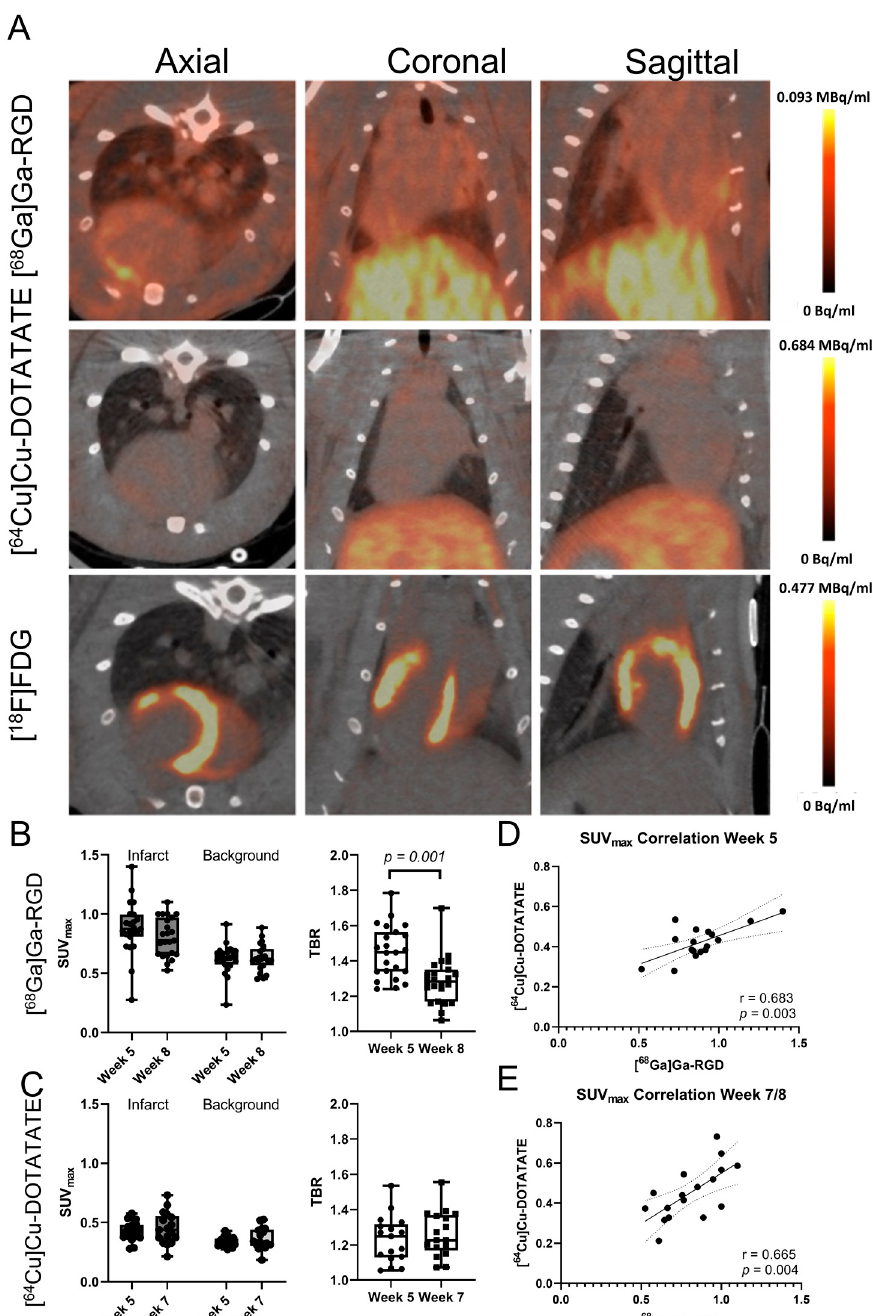
Figure 2. Uptake of [ 68 Ga]Ga-RGD and [ 64 Cu]Cu-DOTATATE in the same rat. The tracers showed infarct-specific uptake in the anterolateral part of the heart (arrows), in the same area which did not have an uptake of 2-[ 18 F]FDG ( A ). Uptake of [ 68 Ga]Ga-RGD in terms of SUV max and TBR ( B ), n = 23. Uptake of [ 64 Cu]Cu-DOTATATE in terms of SUV max and TBR ( C ), n = 17. Correlation between the uptake of [ 68 Ga]Ga-RGD and [ 64 Cu]Cu-DOTATATE before ( D ) and after treatment ( E ). SUV: Standard uptake value; TBR: Target-to-background ratio.